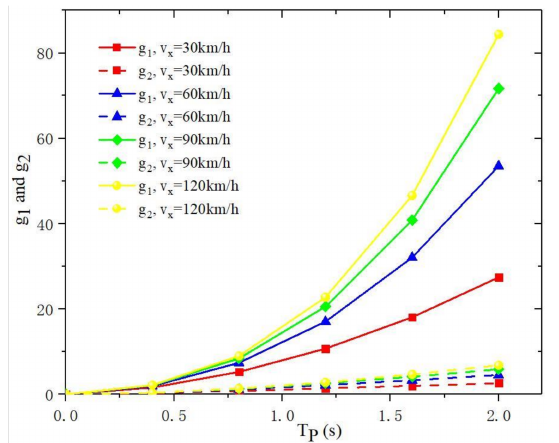
Figure 6. The values of g 1 and g 2 under different preview times T P